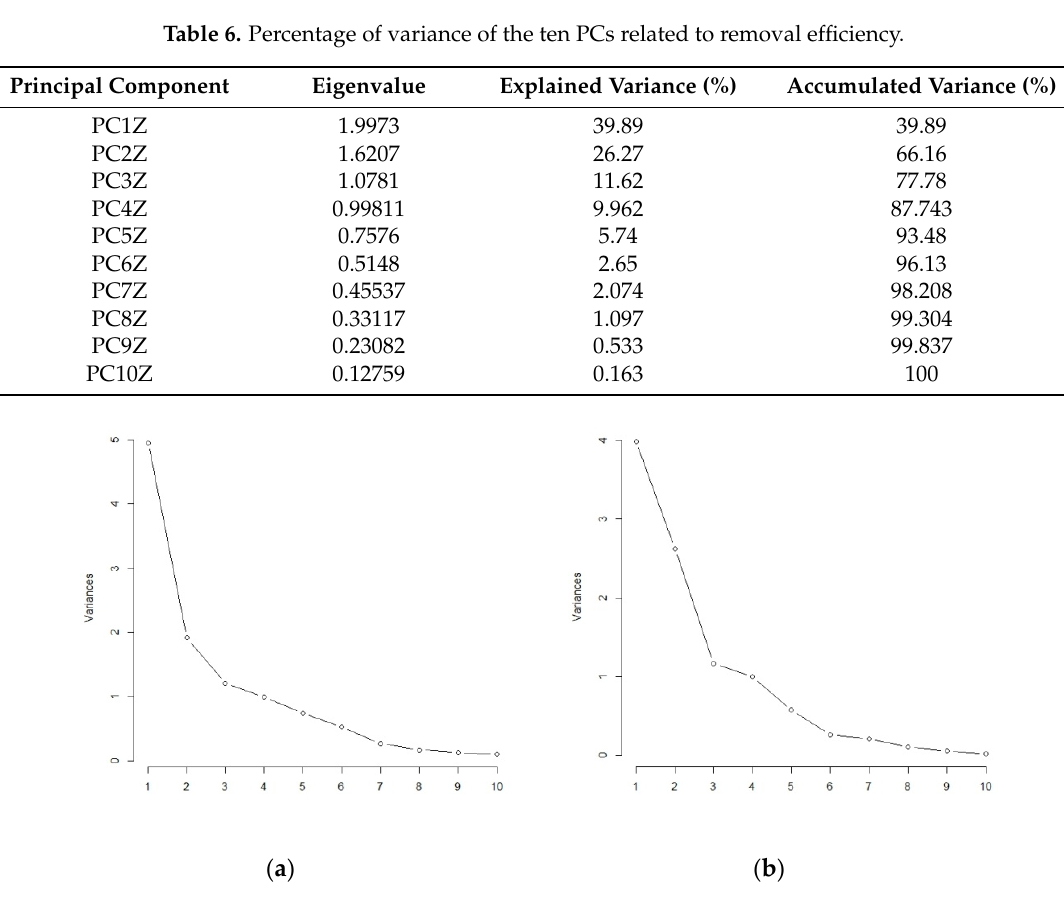
Figure 2. Scree plots of variance vs. PCs for load ( a ) and sustainability ( b